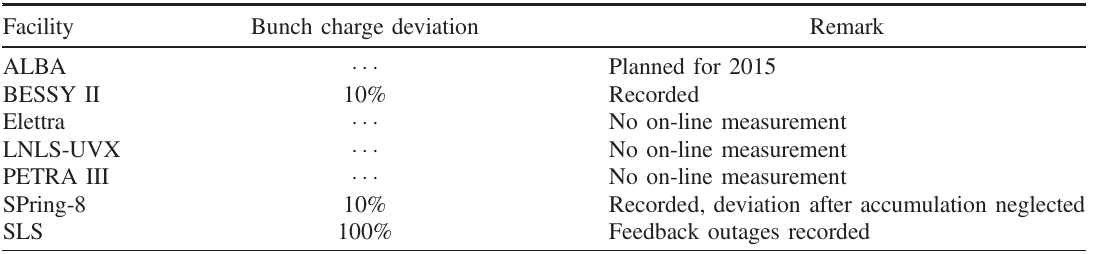
TABLE VII. Distorted-filling limits for different